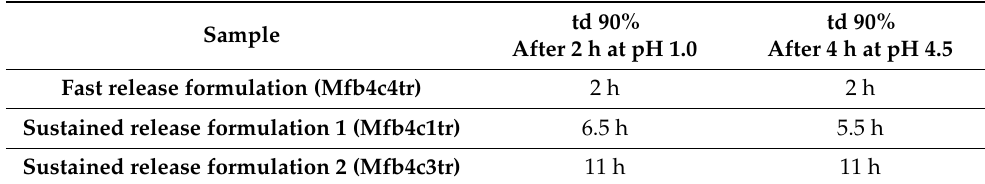
Table 3. Time required for dissolution of 90% of M dose (td 90%) from the sustained release tablet formulations after the pH change.